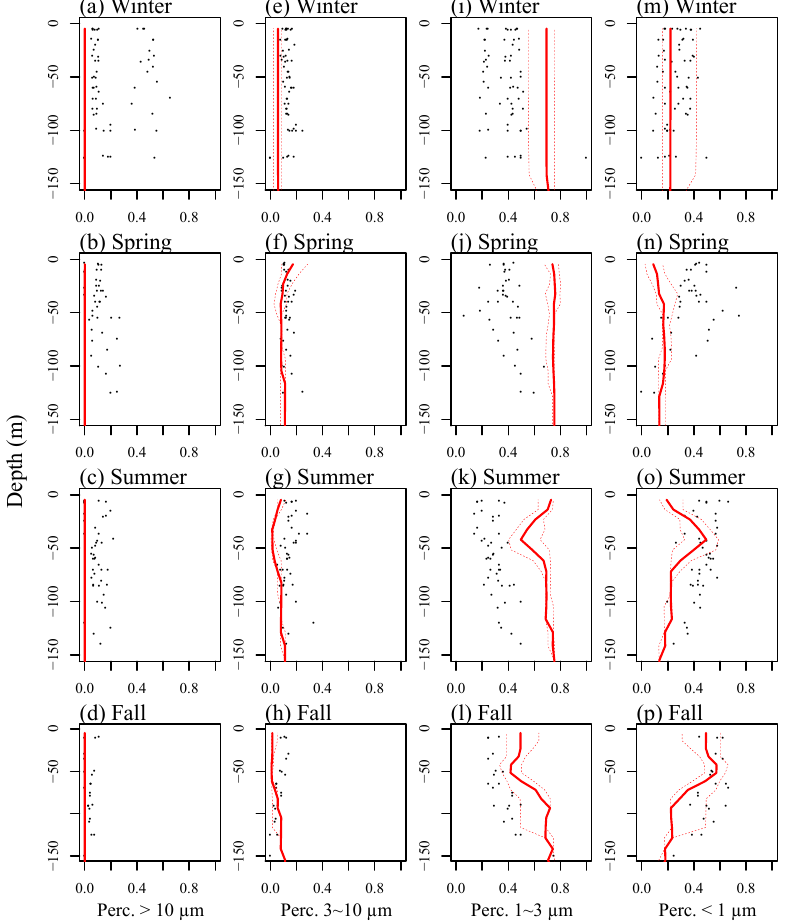
Figure 9. The same as Fig. 8, but for station